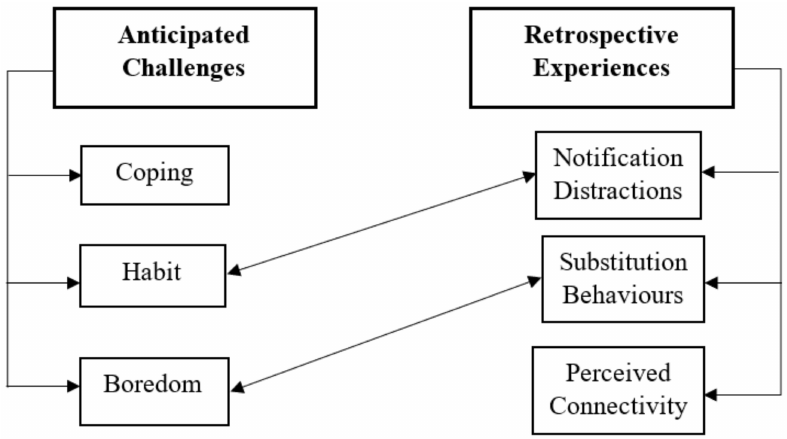
Figure 1. Themes before and after